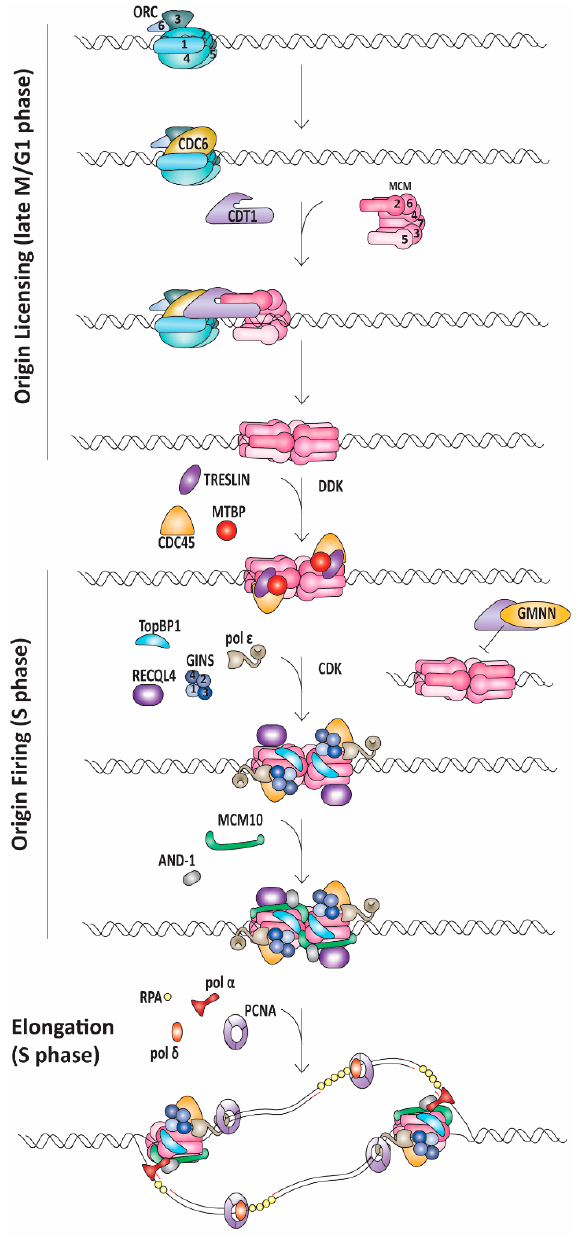
Figure 1. Origin licensing and firing require the coordinated action of multiple protein